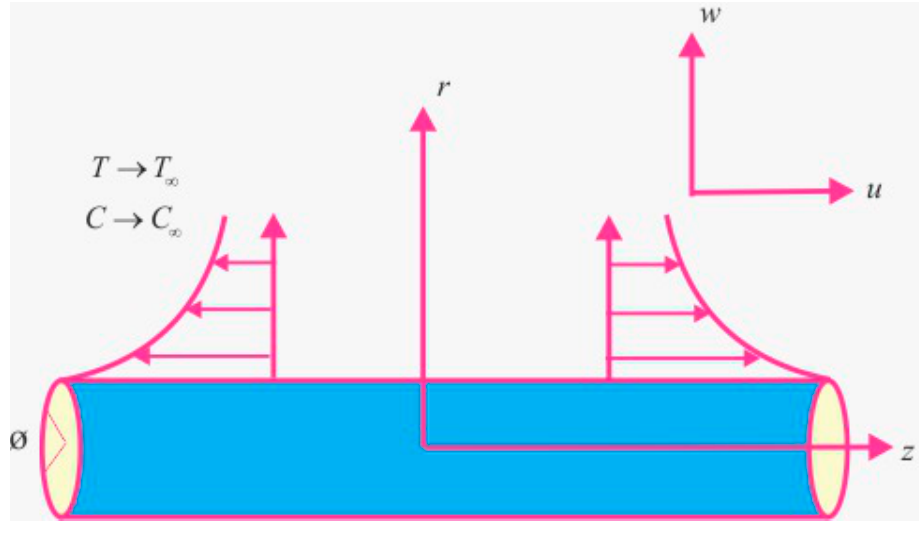
Figure 1. Sketch for the flow field.